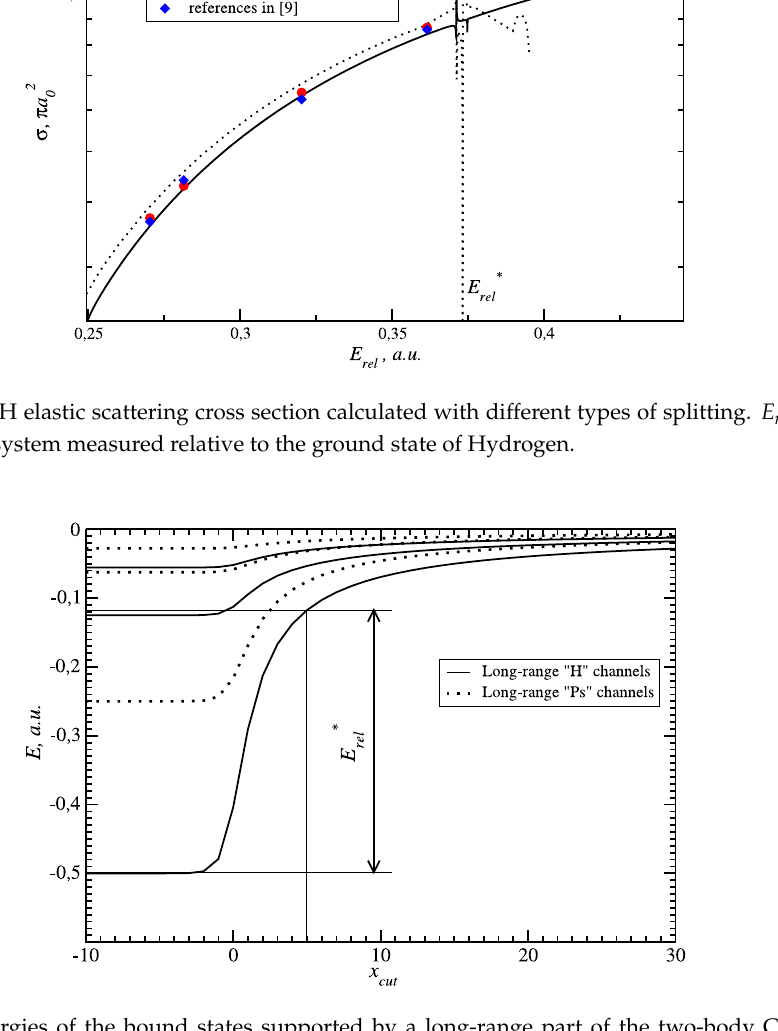
Figure 4. Energies of the bound states supported by a long-range part of the two-body Coulomb potential as a function of the cut-off parameter x cut , Equation (4). The proper asymptote of the Faddeev component for the “two-body” splitting of the Coulomb potential is only secured for the energies below the lowest unphysical bound